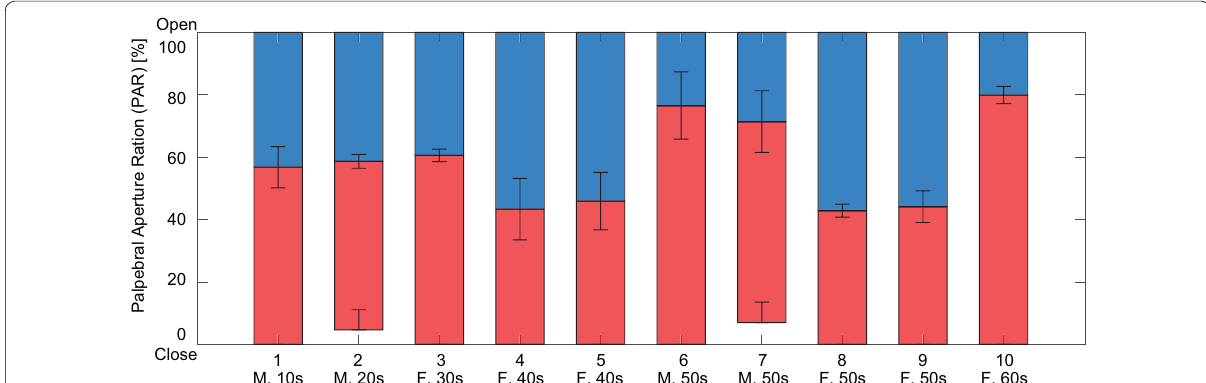
Fig. 9 ELGM evaluation results for patients with facial paralysis. These graphs show changes in PAR for various subjects. The blue bar shows how the PAR value shifts without the robot, and the red bar shows improved eyelid closure with the robot. When eyelid closes, the PAR is 0% and the PAR is 100% when it opens. Error bars in this graph indicate standard errors